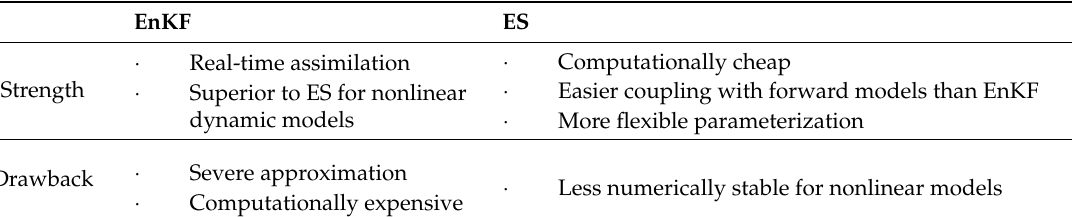
Table 1. Comparison between EnKF and